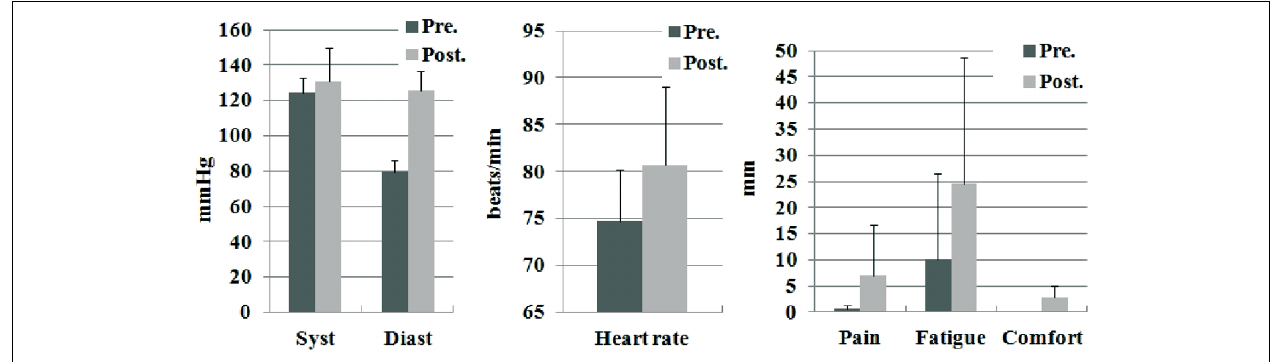
FIGURE 6 | Pre and post condition measures of physiological effort and subjective perceptions. The reported data are average and standard deviation for systolic BP, diastolic BP, heart rate, pain, fatigue, and comfort.